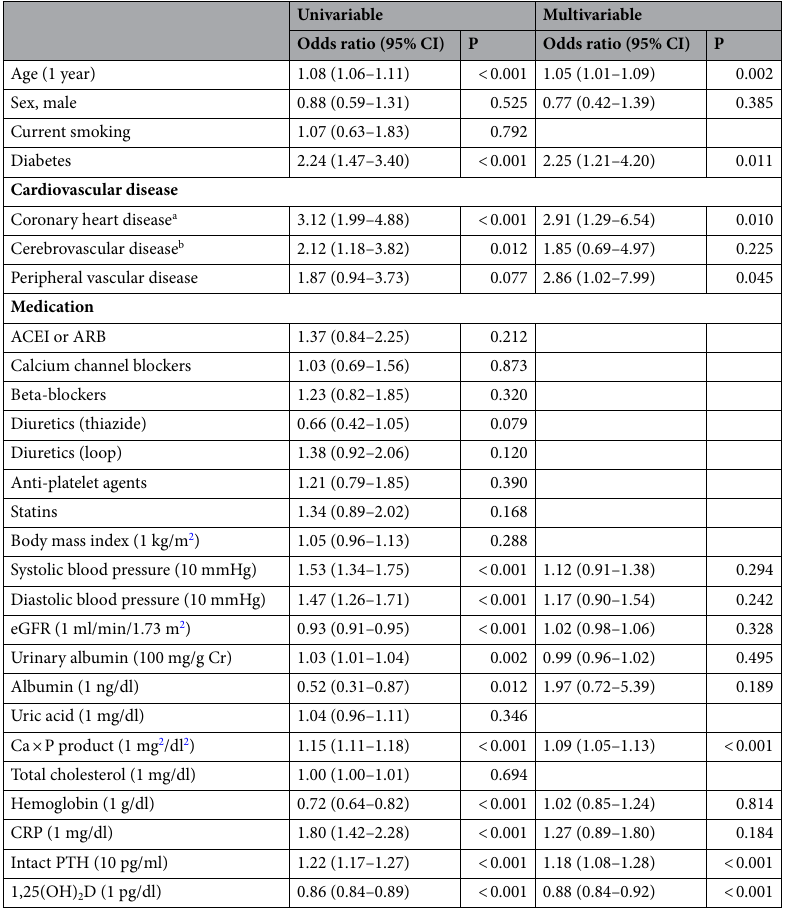
Table 4. Univariate and multivariable analyses for variables associated with at least one valve calcification in the study population (n = 513). Data are presented as odds ratio and 95% confidence interval (CI). coronary angioplasty. b Cerebrovascular disease is defined as a history of stroke or transient ischemic